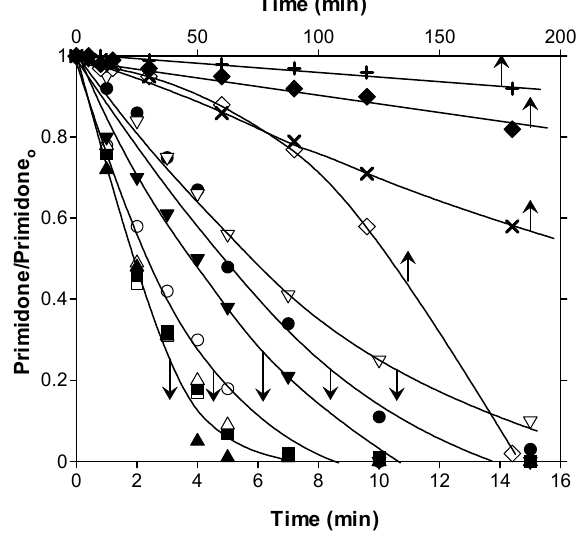
Figure 2. Variation in normalized primidone-remaining concentration (C/C 0 ) with time in experi- ments: without catalyst—ozonation ( ▼ ), photolytic ozonation ( ▽ ) and photolysis (+); with bare TiO 2 , CatOz ( ▲ ), PhCatOz ( Δ ) and PhCat (x); with GOTi, CatOz ( █ ), PhCatOz (*) and PhCat ( ◊ ); and with FeGOTi, CatOz ( ○ ), PhCatOz ( ) and PhCat ( ◆ ). Conditions: gas flow rate, 35 L h − 1 ; inlet ozone gas concentration, 10 mg L − 1 ; primidone initial concentration, C 0 = 10 mg L − 1 ; catalyst dosage, 0.25 g L − 1 ; agitation speed, 700 rpm .